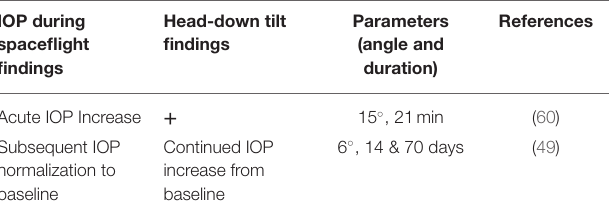
TABLE 2 | Intraocular pressure findings during spaceflight and head-down tilt bedrest